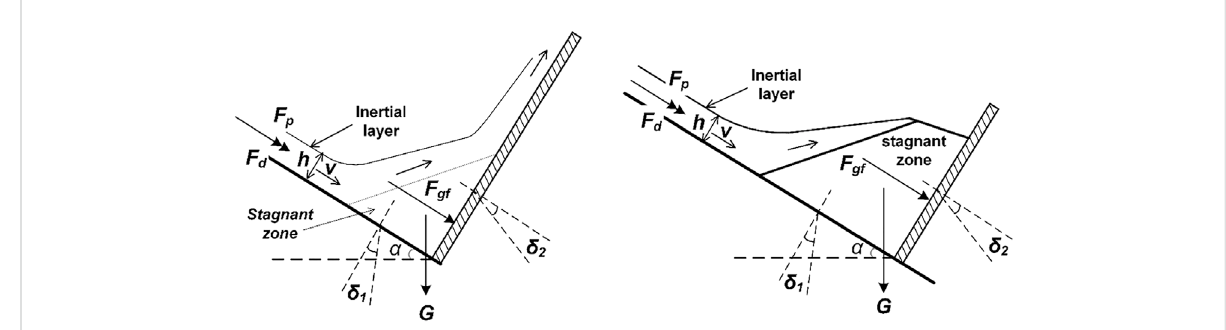
FIGURE 1 Dragforce( F d ),passiveearthforce( F p )andgravity-and-frictionforce( F gf )respectivelyproducedbyinertiallayerandstagnantzoneinagranular fl ow impact event for two kinds of impact mode. δ